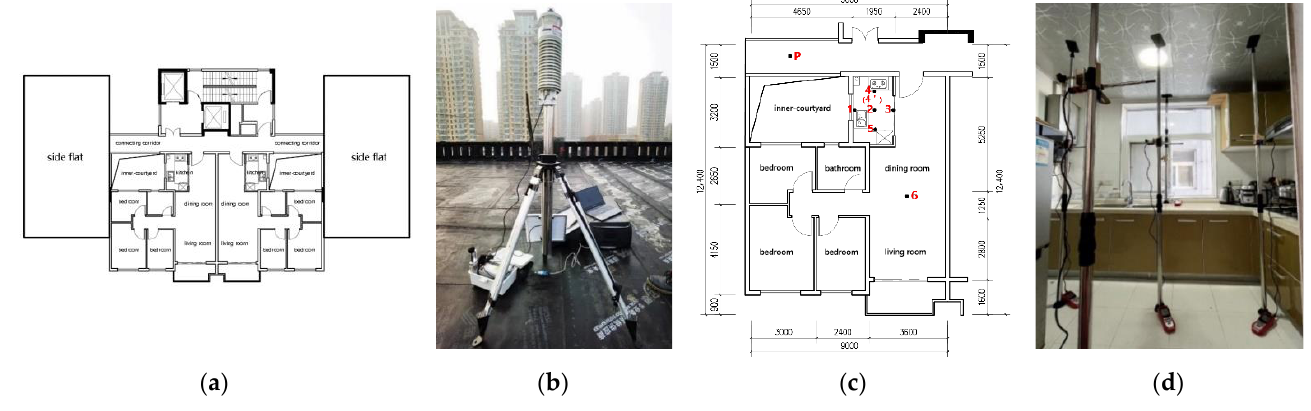
Figure 3. The flat of measurement: ( a ) plan view; ( b ) arrangement of outdoor measurement points. ( c ) Location of measurement points; ( d ) arrangement of indoor measurement points.